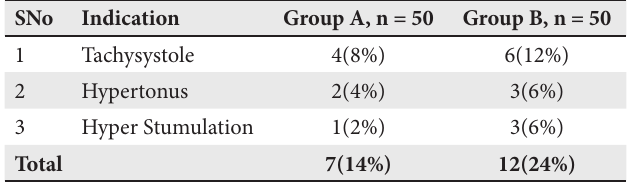
Table 2 : Abnormal contractility pattern